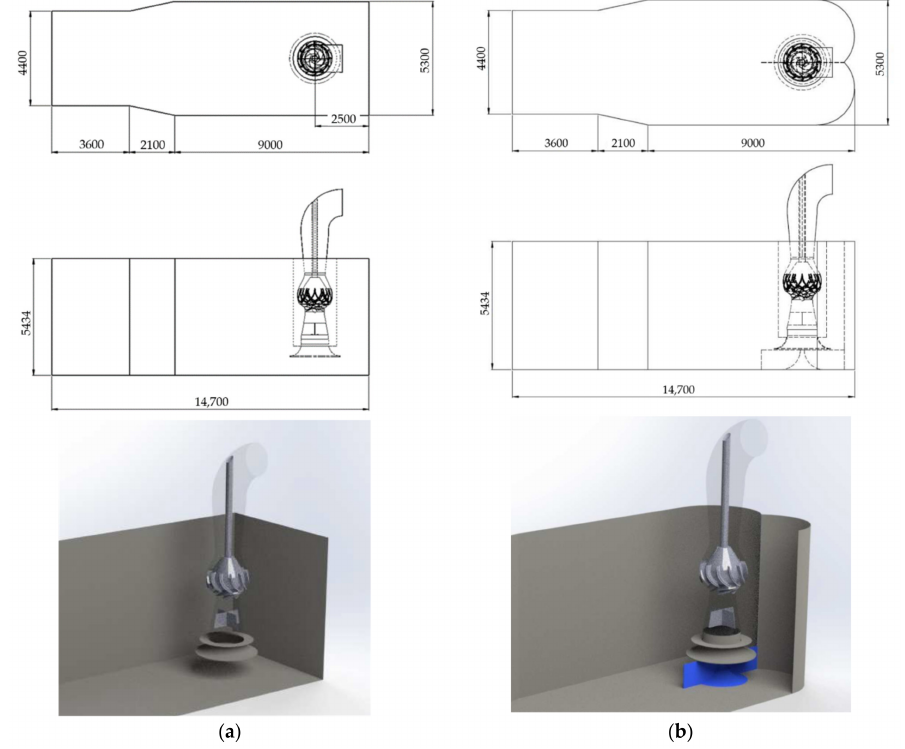
Figure 11. ( a ) A rectangular pump sump model with mixed-flow pump and guidevane (Case 1); ( b ) a pump sump utilizing semicircular arches as a backwall (Case 2). In addition, a floor cone and a splitter are installed to prevent floor sub-surface